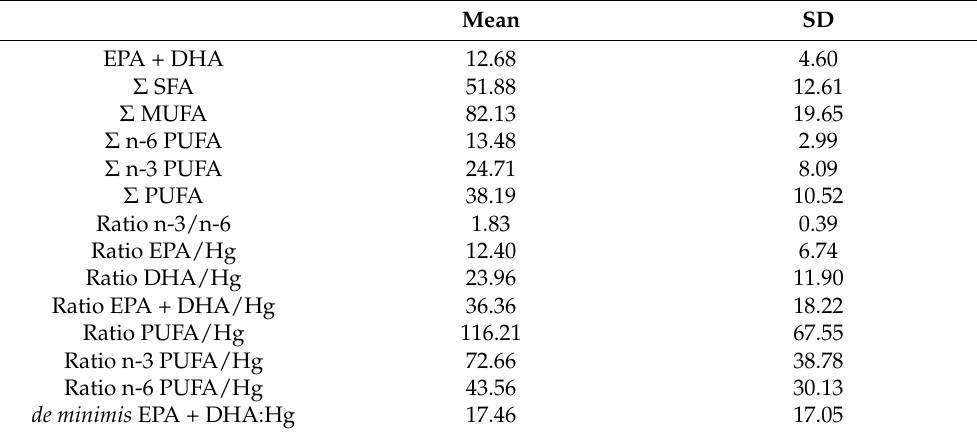
Table 5. Fatty acids composition (expressed as mg/g fish muscles) and fatty acids ratio (mg)/mercury ( µ g) in muscles of the European eel ( Anquilla anquilla L.).